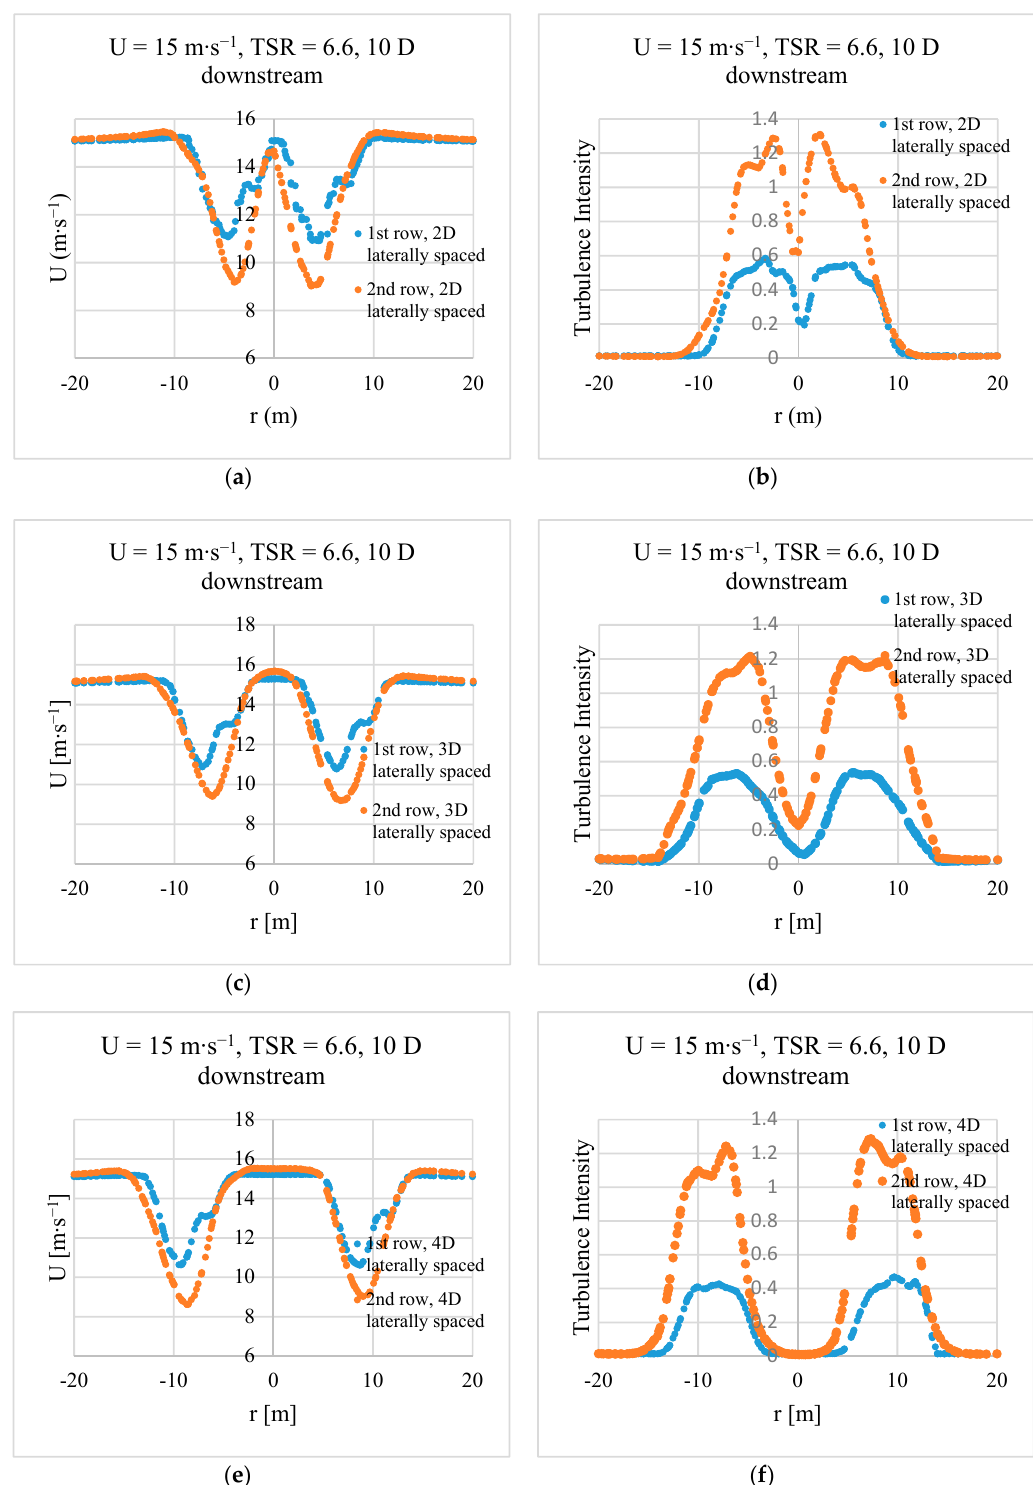
Figure 6. Wake interaction effect, showing wake data plots in the wake of the first and second rows for different lateral spacing in terms of rotor diameter (D): ( a ) Axial velocity for 2 D of lateral spacing; ( b ) TI for 2 D of lateral spacing; ( c ) axial velocity for 3 D of lateral spacing; ( d ) TI for 3 D of lateral spacing; ( e ) axial velocity for 4 D of lateral spacing; ( f ) TI for 4 D of lateral spacing. The spacing distances refer to hub rotor distances.